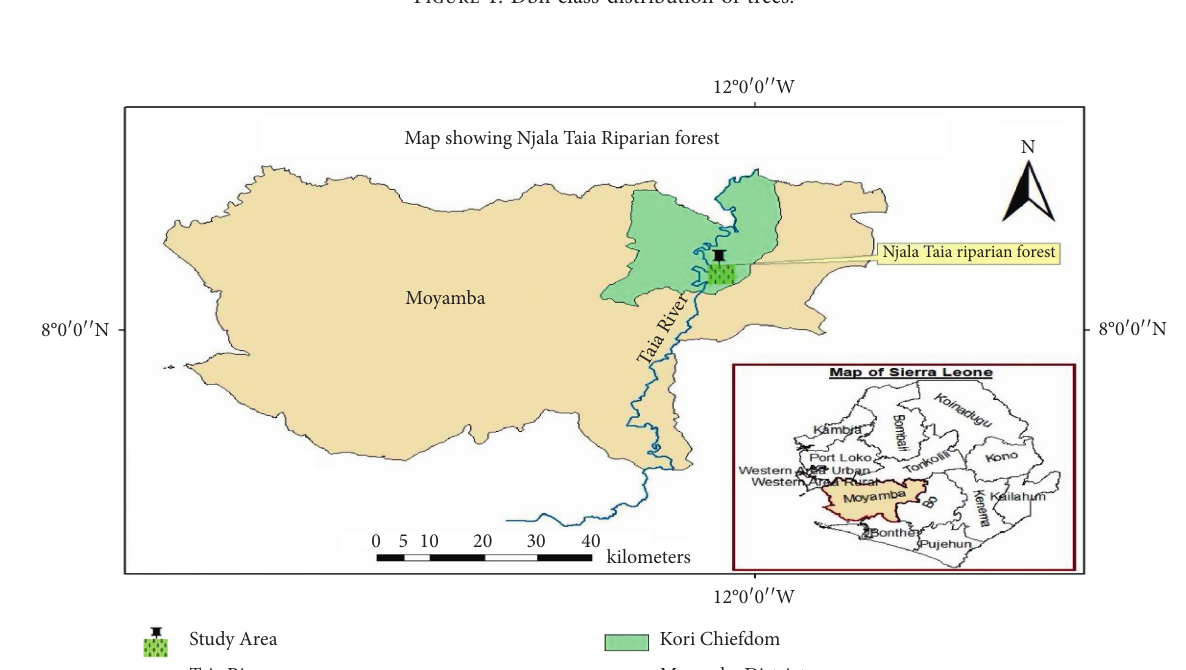
Figure 2: Map showing Taia River and its Riparian Forest.